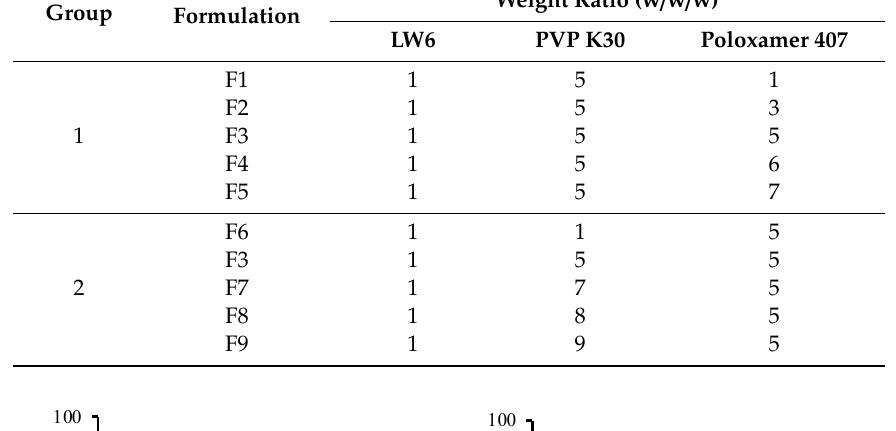
Table 2. Composition of ternary SDs at the di ff erent weight ratios (w / w).